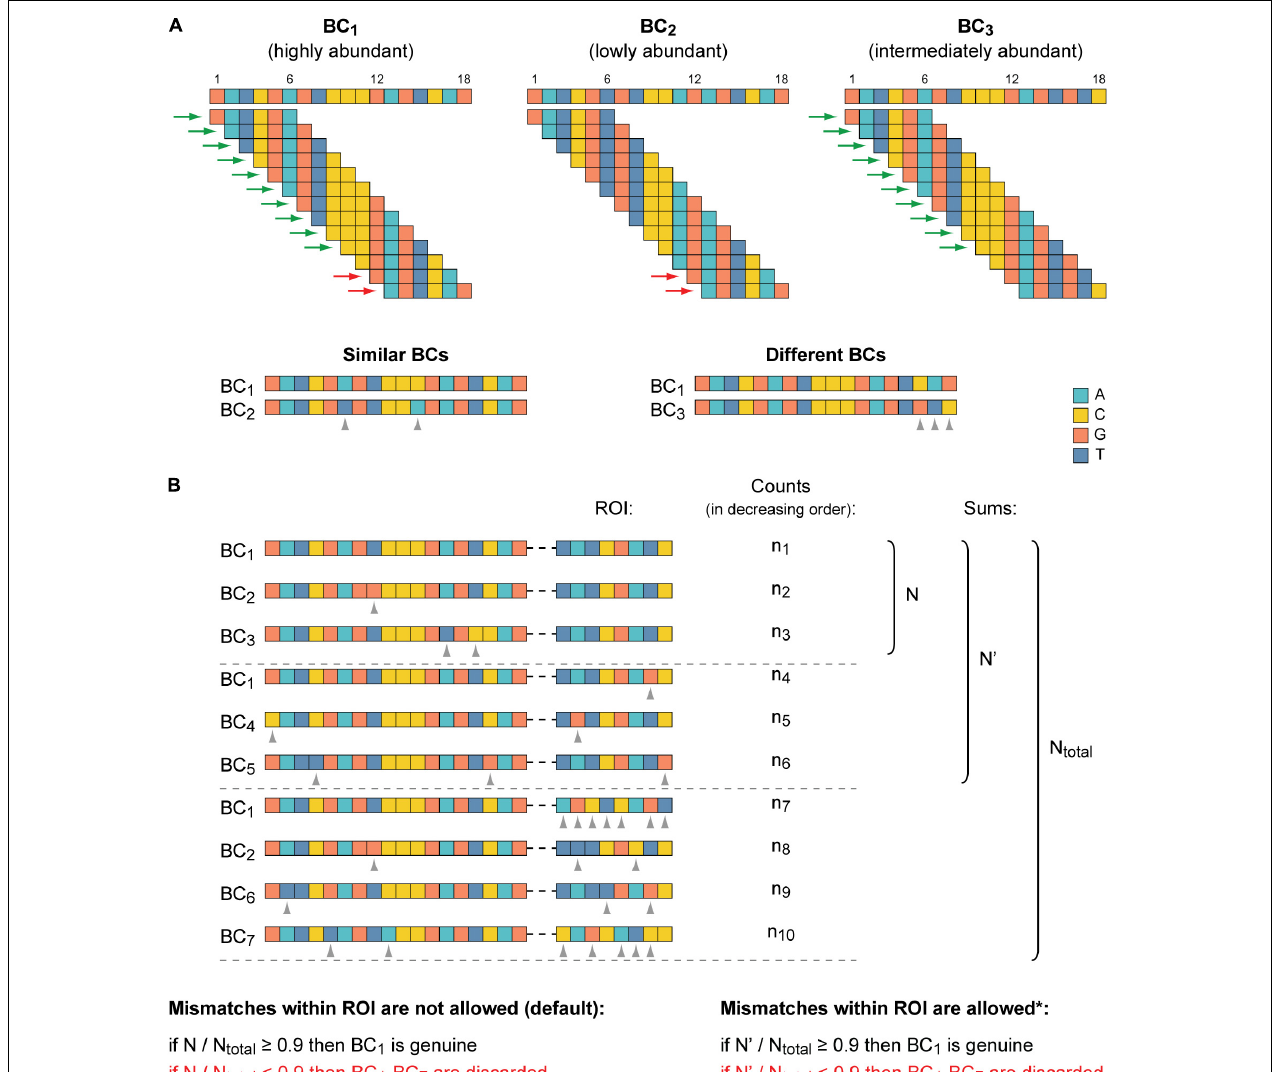
FIGURE 3 | Identification of genuine BCs, their mutant variants, and associated ROIs. (A) The clustering of similar BC sequences is achieved by their decomposition into overlapping k-mers and by the subsequent pairwise alignment of BCs that share identical k-mers. At the top, three BCs are shown as an example. K-mers (6-mers) shared by BC 1 and BC 2 and by BC 1 and BC 3 are indicated by red and green arrows, respectively. At the bottom, the pairwise sequence alignment of the candidate similar BC sequences is depicted. The BC 1 and BC 2 are recognized to be similar because their sequences differ from each other only at two positions ( ≤ the maximum allowed error rate). BC 1 and BC 3 are considered to be different because their sequences differ from each other at three positions ( > the maximum allowed error rate) even though these BCs share more common k-mers than the BC 1 and BC 2 . (B) Identification of genuine BCs. One cluster of seven similar BCs along with the associated ROI sequences is shown as an example. BC 1 is the most abundant BC (as in A ) and the ROI sequence, which is associated with it most frequently (n 1 > n 4 and n 1 > n 7 ), is considered as the putative ROI for the cluster. By default, if the putative ROI is supported by at least 90% of normalized read counts calculated for all ROI sequences found in the cluster, the BC 1 becomes genuine. Otherwise, the entire cluster is excluded from the subsequent analysis. Optionally (indicated by an asterisk), if mismatches within the ROI are permitted (e.g., a difference at one position could be allowed for the example data set), then normalized read counts for the putative ROI and its allowed mutants are summed. Notice that differences between the ROI sequences associated with similar BCs should be allowed with caution, especially for very short ROIs. Dashed horizontal lines separate different groups of ROIs: the putative sequence, its allowed mutants, and all other sequences. Gray arrowheads denote mismatches in both